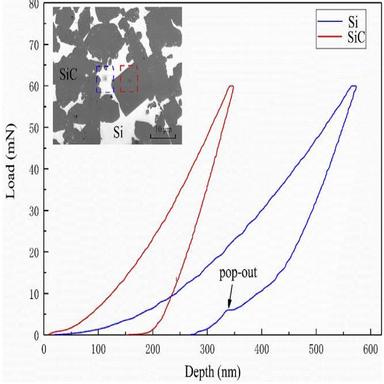
The surface topography and corresponding load–depth curves of representative indentations conducted on the Si/SiC surface.